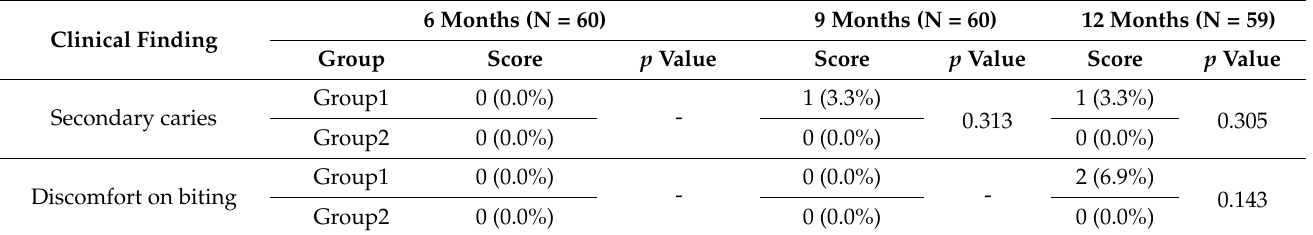
Table 5. Statistical evaluation of two parameters for the clinical evaluation of restorations.